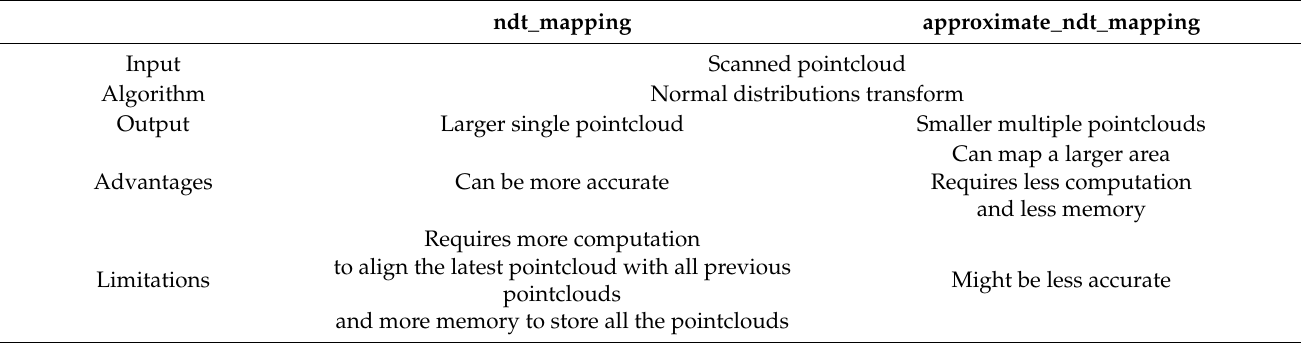
Table 9. Comparison of mapping nodes provided in Autoware.